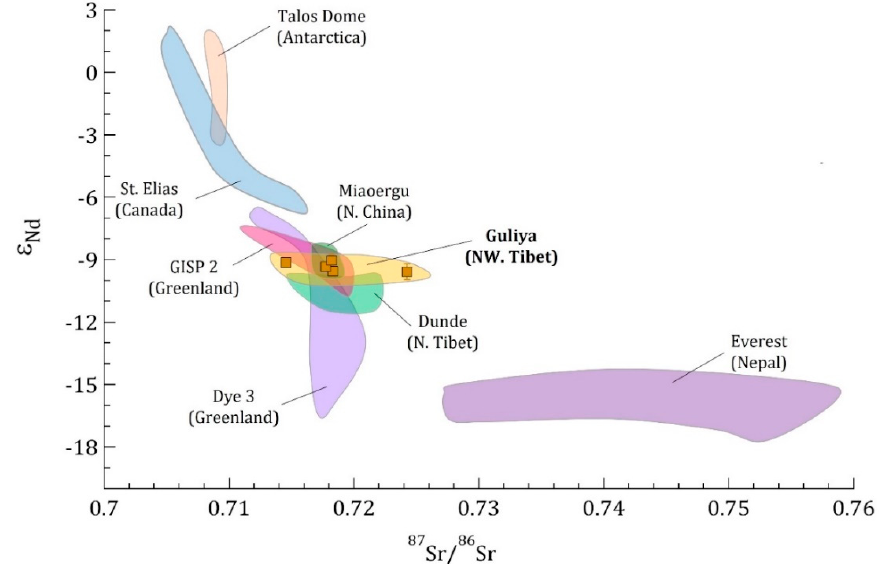
Figure A6. ε Nd vs. 87 Sr/ 86 Sr of the five Guliya dust filters (brown squares) compared to Sr and Nd isotopic arrays of dust sampled in ice cores from: Dunde (China [35]), Miaoergou (China [43]), Everest (Nepal [44]), Mt. St. Elias (Canada [34]), GISP2 (Greenland [26]), Dye 3 (Greenland [22]) and Talos Dome (Antarctica [100]). These ice cores cover different time scales. Table A1. TE enrichment factor of dust filters relative to the UCC [69]. Ti is the crustal element of reference and its concentration (ppm) in each sample is displayed in italics.